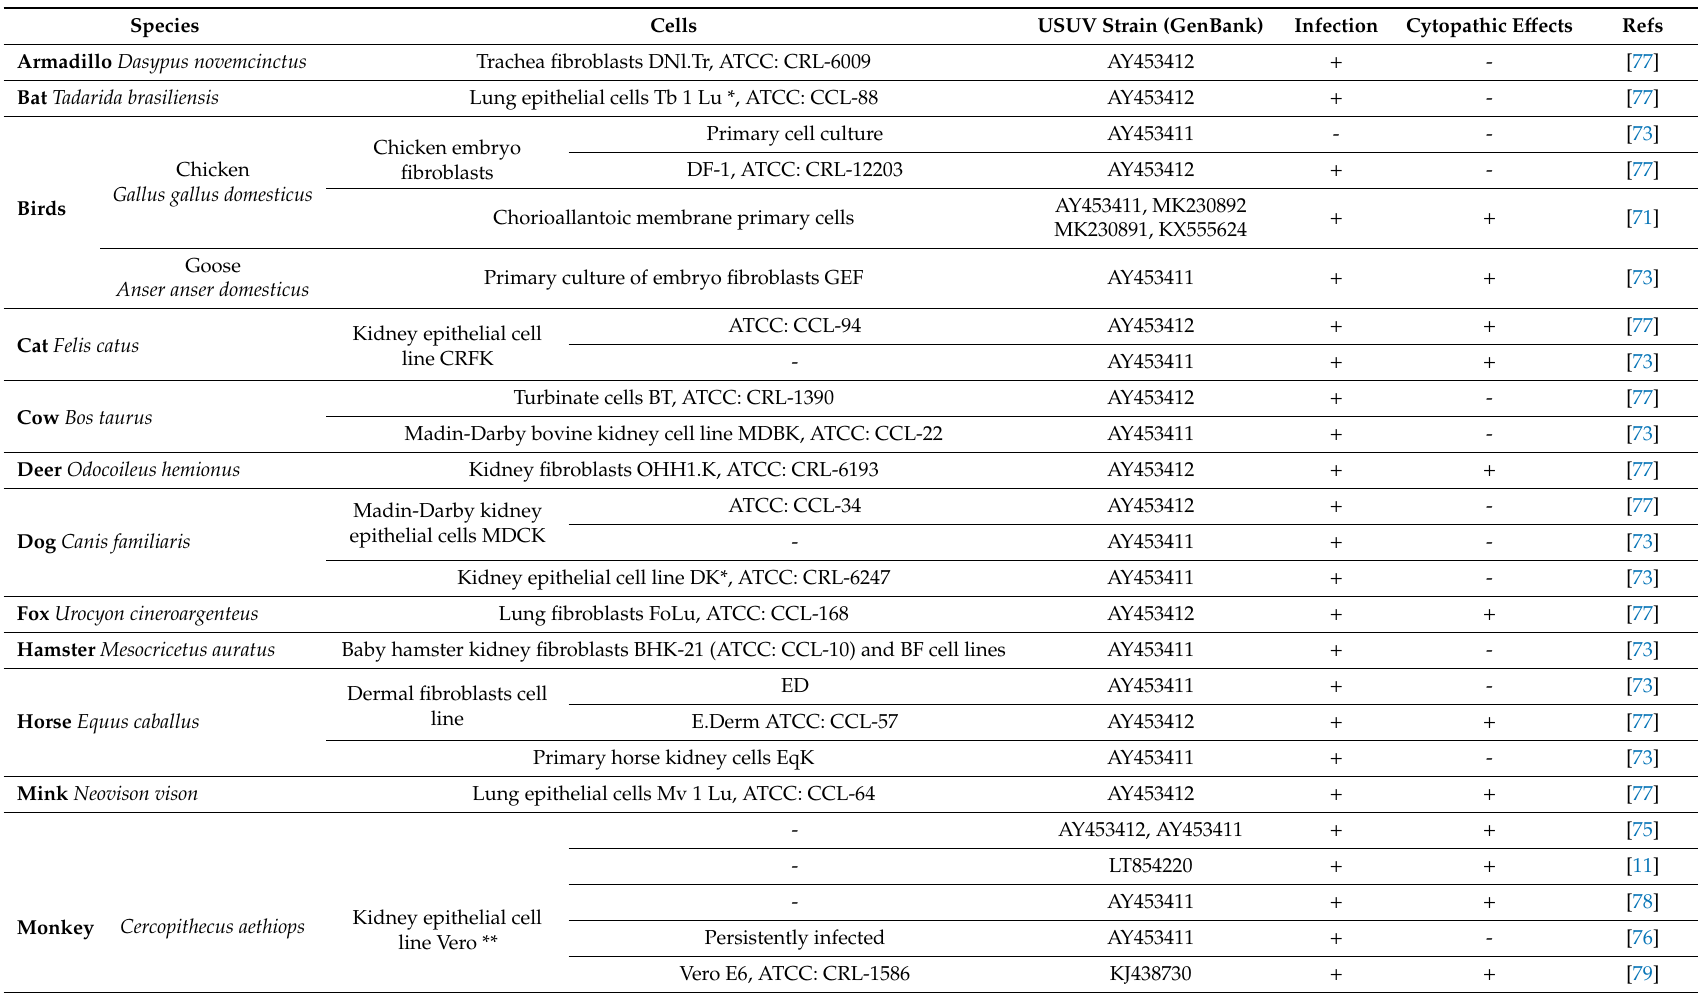
Table 1. List of animal cells used for the characterization of Usutu virus